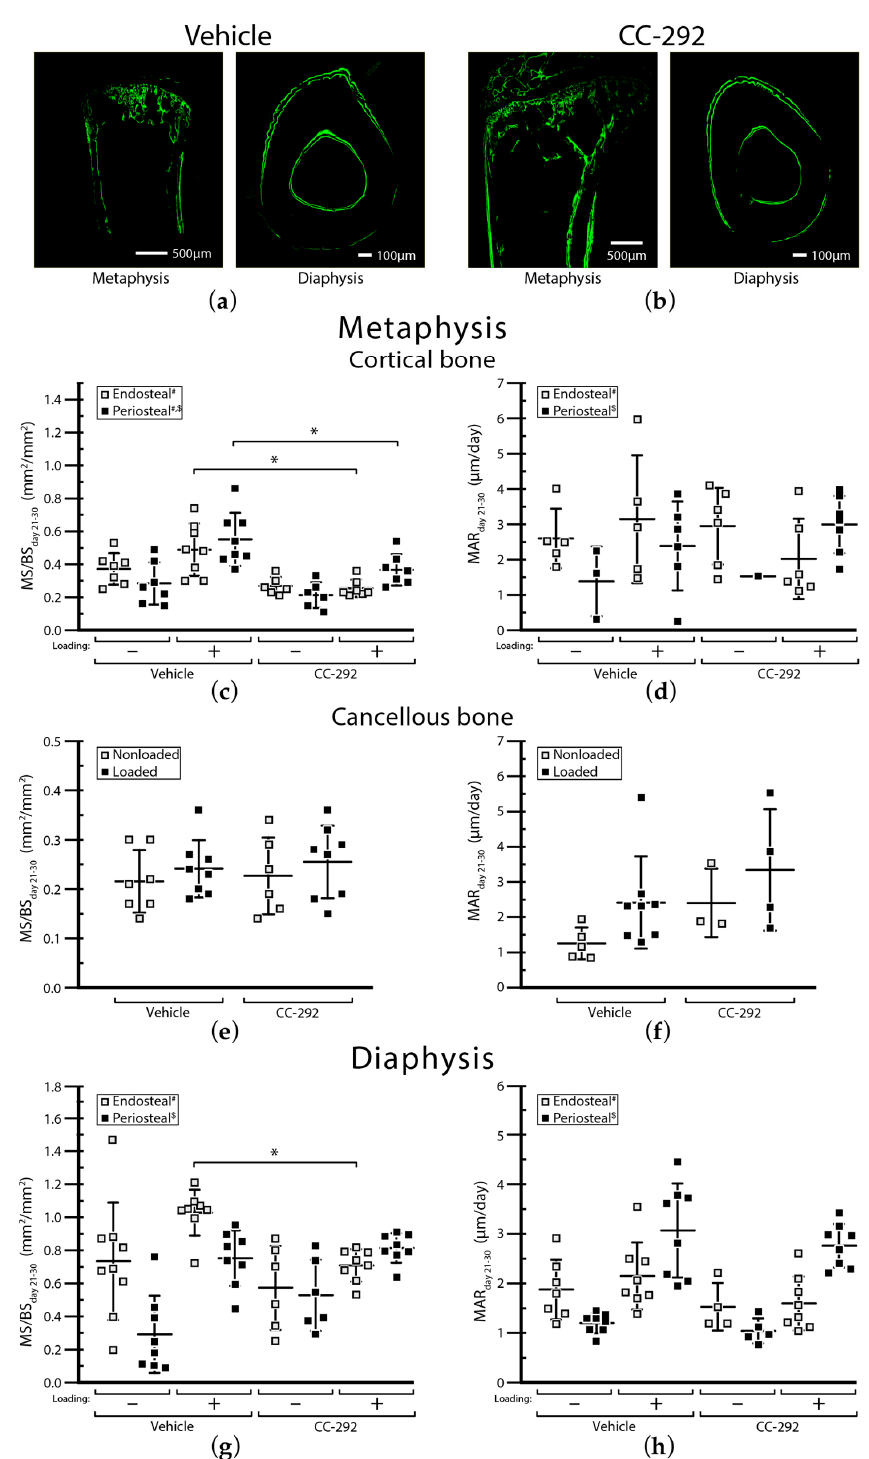
Figure 5. Conventional histomorphometry. Shown ( a , b ) are representative images of calcein-labeled sections of the metaphysis (upper) or diaphysis (lower) of either vehicle or CC-292 treated mice. Plotted are ( c ) mineralized surface area (MS/BS) and ( d ) mineral apposition rate (MAR) in metaphyseal cortical bone, ( e ) MS/BS and ( f ) MAR in metaphyseal cancellous bone, and ( g ) MS/BS and ( h ) MAR in diaphyseal bone between days 21 and 30 measured in the ROI at either the endosteal or the periosteal surface in all groups (vehicle, CC-292) either nonloaded ( − ) or loaded (+). Plots show individual values together with mean ± SD. ANOVA main effects: (#) treatment, ($) loading, * p <